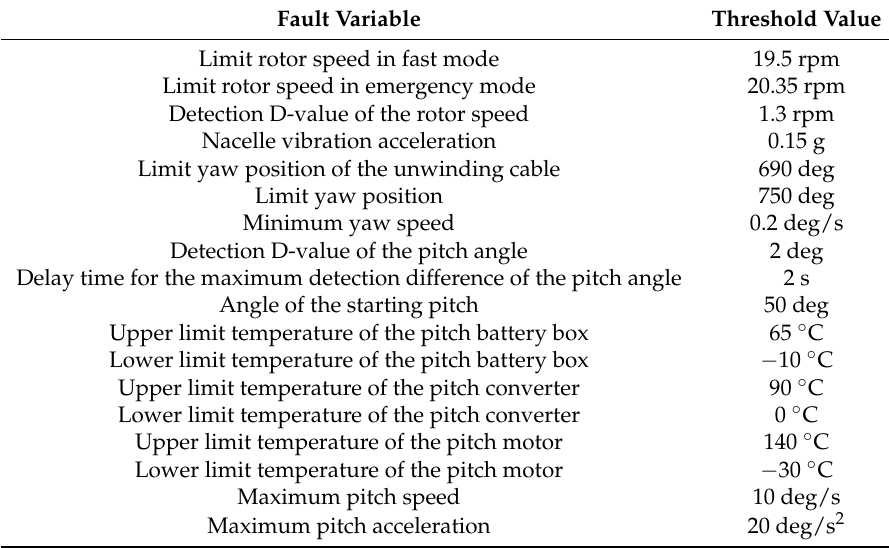
Table 3. Threshold values of the fault